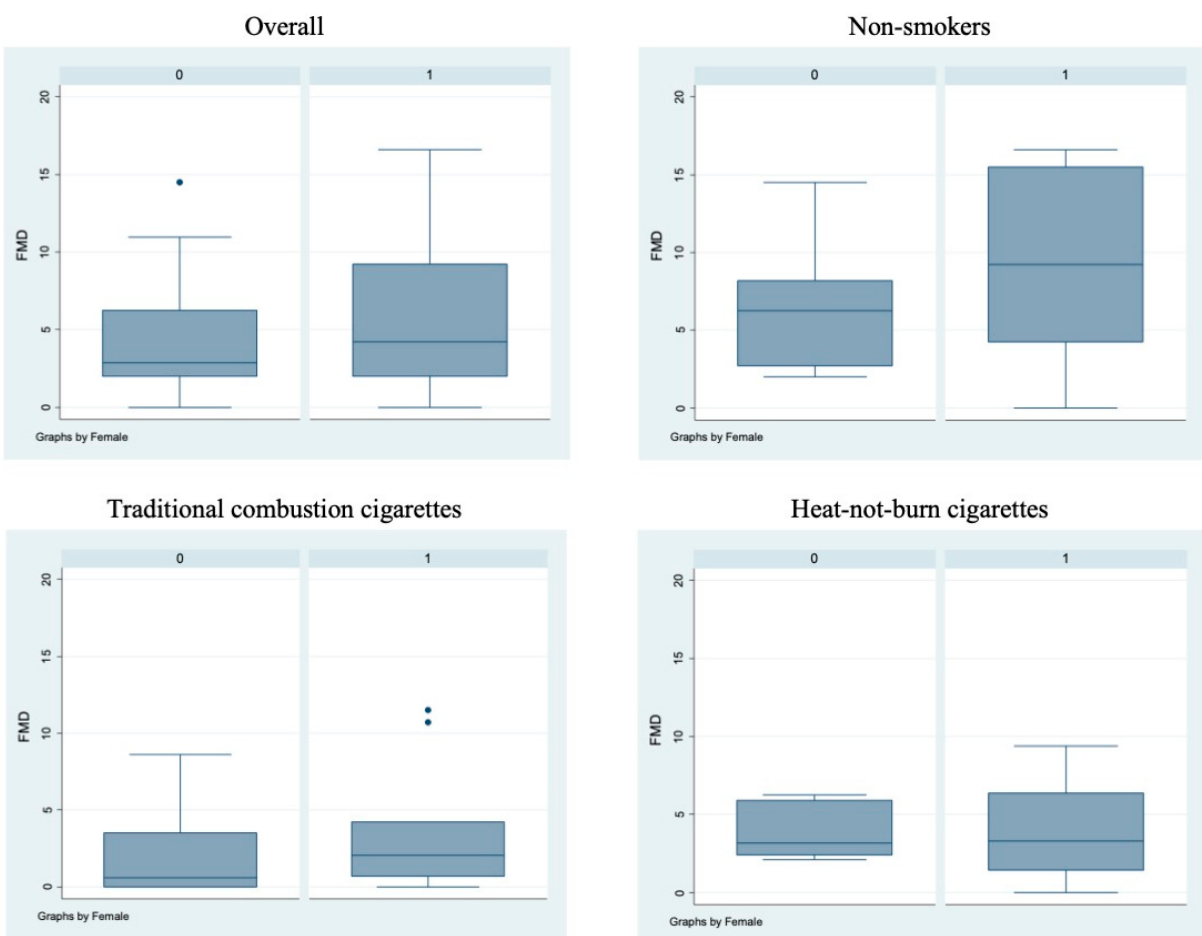
Figure 1. Flow-mediated dilation values in the different sub-populations. Box-and-whisker plots representing flow-mediated dilation values (%) in the overall cohort and in non-smokers, TCCs- smokers and HNBCs-smokers subgroups. 0 = males; 1 = females; • = outlier sample.